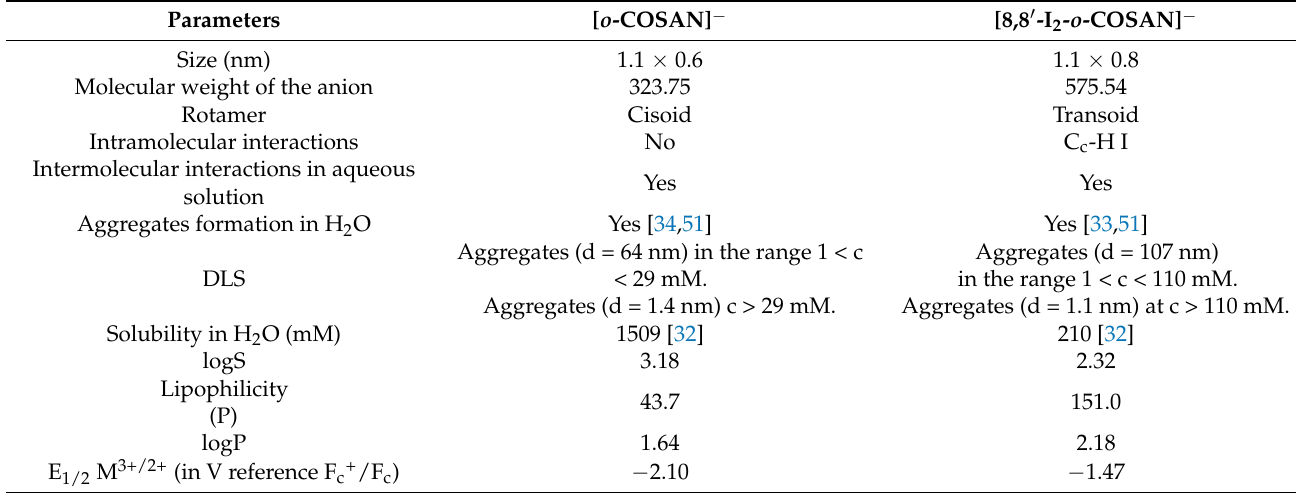
Table 1. The chemical and physicochemical parameters of the two cobaltabis(dicarbollides), Na[ o -COSAN] and Na[8,8 (cid:48) -I 2 - o -COSAN].